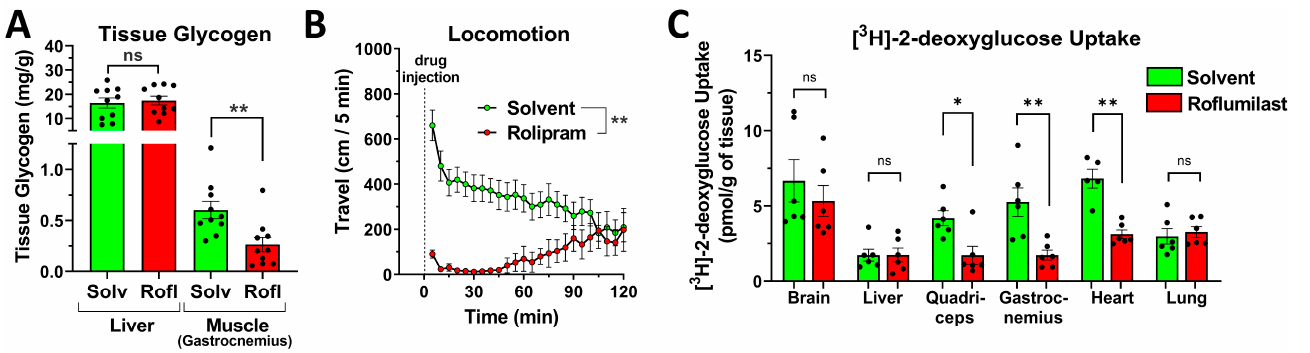
Figure 8. PDE4 inhibition induces glycogenolysis in skeletal muscle and inhibits glucose uptake in skeletal muscle and heart. ( A ) PDE4 inhibition induces glycogenolysis in skeletal muscle. The glycogen levels in the liver and skeletal muscle (gastrocnemius) in postprandial mice are shown after treatment with the PAN-PDE4 inhibitor roflumilast (Rofl; 5 mg/kg; i.p.) or solvent control (Solv) for 90 min. Data are expressed as mg of glycogen per g of tissue weight. ( B ) PAN-PDE4 inhibition reduces locomotion, as reflected by reduced travel distance. Mice were injected with the PDE4 inhibitor rolipram (3 mg/kg; i.p.; n = 6) or solvent control, placed immediately in a new cage, and then locomotion was assessed using SmartCageTM technology. Traces represent changes in travel distance (cm per 5 min interval). ( C ) Postprandial mice were injected with the PDE4 inhibitor roflumilast (5 mg/kg; i.p.) or solvent control, followed 15 min later by injection with [ 3 H]-2-deoxyglucose (intravenous, i.v.). Animals were euthanized 30 min after the tracer injection, their tissues were homogenized, and the phosphorylated [ 3 H]-2-deoxyglucose-6-phosphate was isolated by anion exchange chromatography and quantified by scintillation counting. Data are expressed as pmol [ 3 H]-2-deoxyglucose-6-phosphate per g of tissue wet weight. All data represent the mean ± SEM. Statistical significance was determined using the Mann–Whitney test (bar graphs) or a two-way ANOVA with Sidak’s post hoc test (time courses) and is indicated as ns ( p > 0.05), * ( p < 0.05), and ** ( p < 0.01).